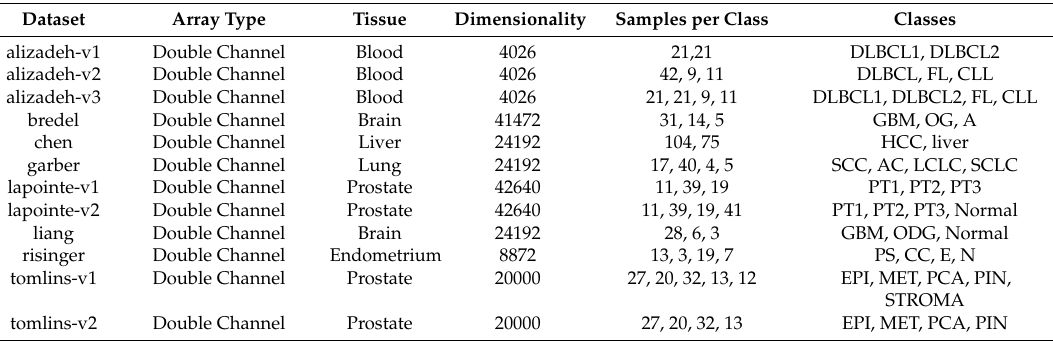
Table 7. Specification of cancer gene-expression